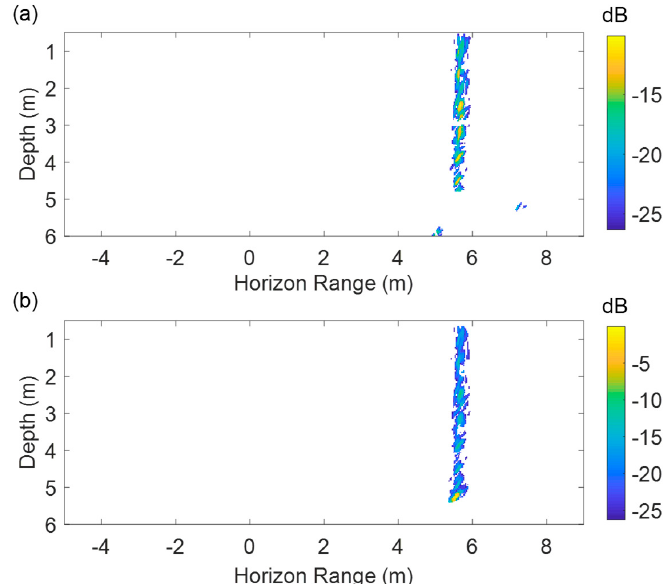
Figure 11. Results obtained by screening the data in Figure 7 using thresholds of image amplitude and velocity intensity. ( a ) and ( b ) correspond to the processing results of Scheme A and Scheme B, respectively.